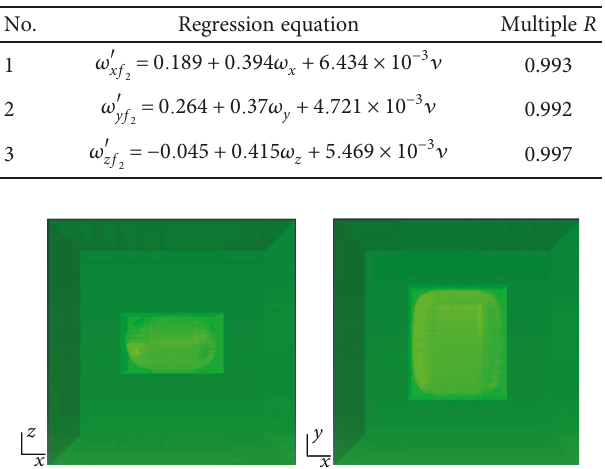
′ of the surface regression equations. zf 2